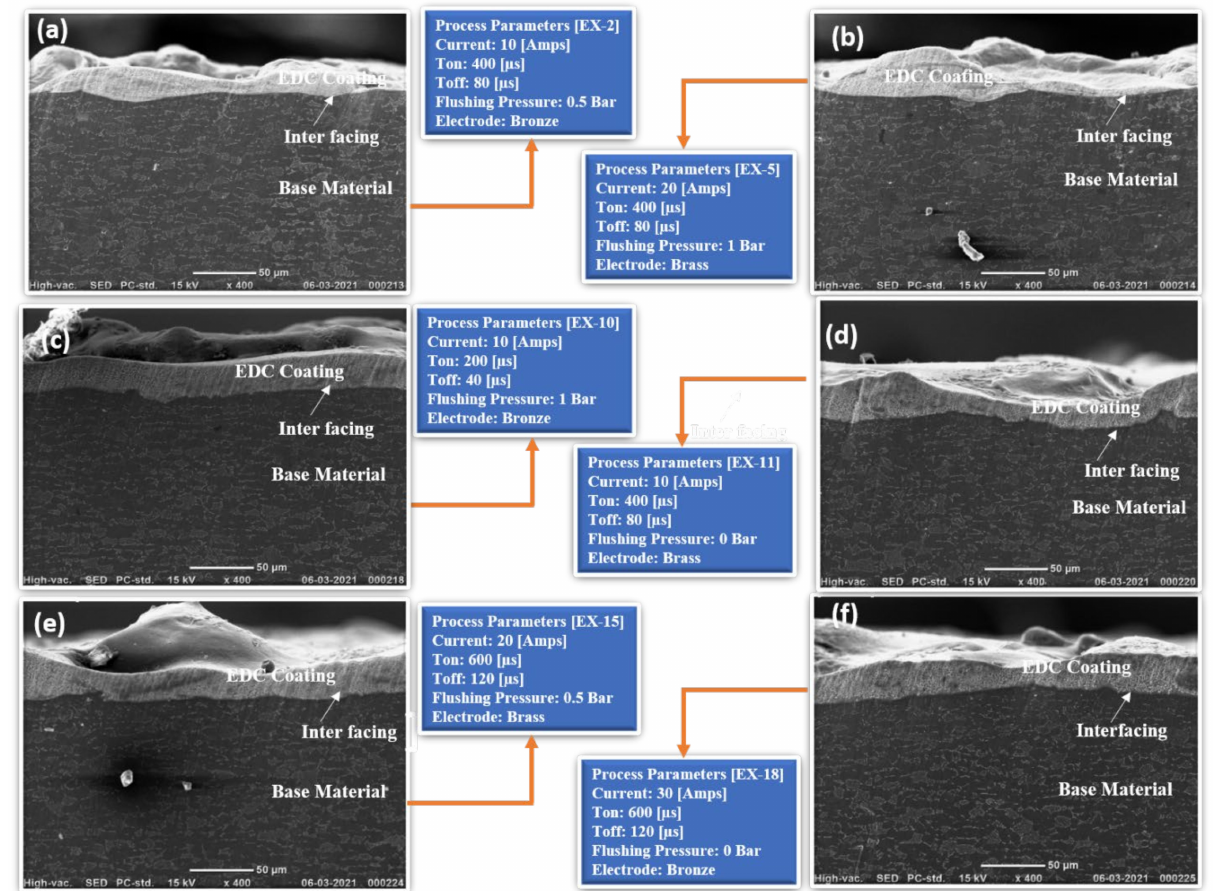
Figure 6. More SEM details about the interfacing and bonding of coating on base material: ( a ) EX 2, ( b ) EX 5, ( c ) EXP 10, ( d ) EX 11, ( e ) EX 15 and ( f ) EX 18 (all SEM images are 400 ×